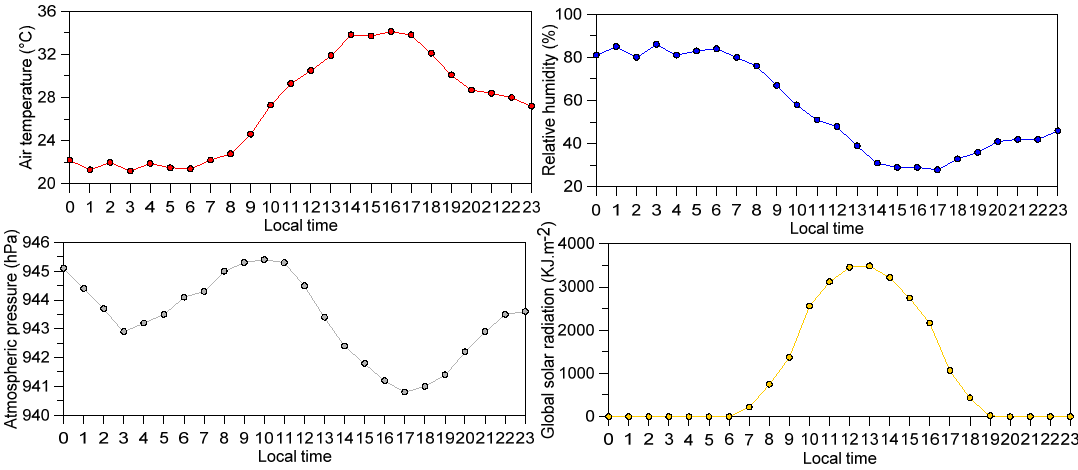
Figure 3. Weather data from the Brazilian National Institute of Meteorology (INMET) station on 21 October 2014.